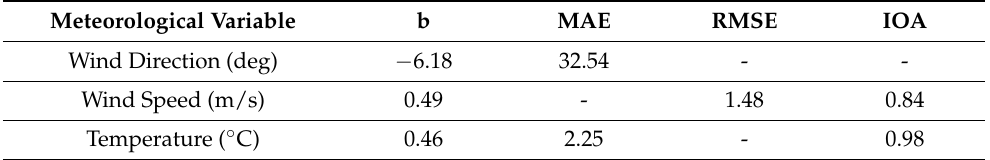
Table A2. 2011 Statistics for WRF Extracted Points Compared to Observations at Saint Paul Down- town Airport.